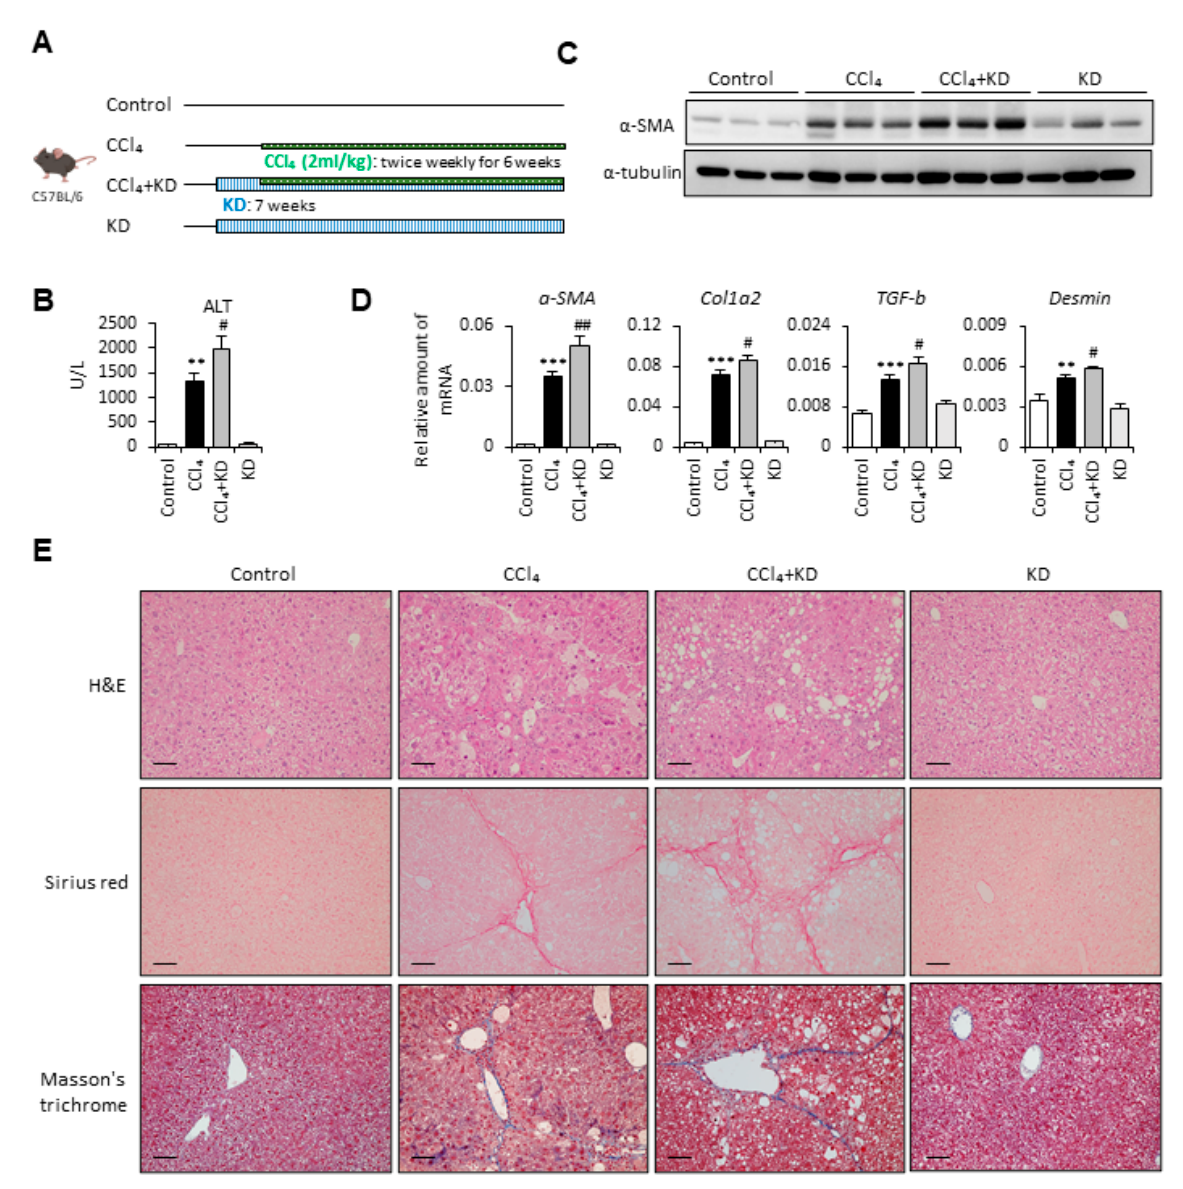
Figure 1. Ketogenic diet enhanced the severity of carbon tetrachloride (CCl 4 )-induced liver fibrosis. ( A ) Study design of the in vivo experiment. ( B ) Serum samples were collected at the end of the experiment, and the serum alanine aminotransferase (ALT) was assessed. ( C ) Representative results from Western blot analyses of α -SMA expression and ( D ) qPCR analyses of α -SMA, Col1a2, transforming growth factor- β (TGF- β ), and Desmin gene expression. ( E ) Representative hematoxylin and eosin (H&E), Sirius red, and Masson’s trichrome staining images of liver tissues. Scale bars: 0.1 mm. **, p < 0.01; ***, p < 0.001 vs. white bar. #, p < 0.05; ##, p < 0.01 vs. black bar. N = 5 in each group. Data are shown as means ± SEM.